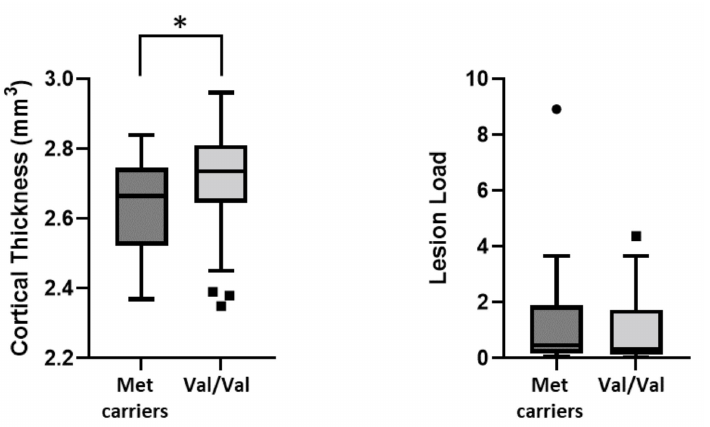
Figure 3. Association between BDNF Val66Met polymorphism and structural MRI measures. Legend: (*) denotes statistical significance ( p <